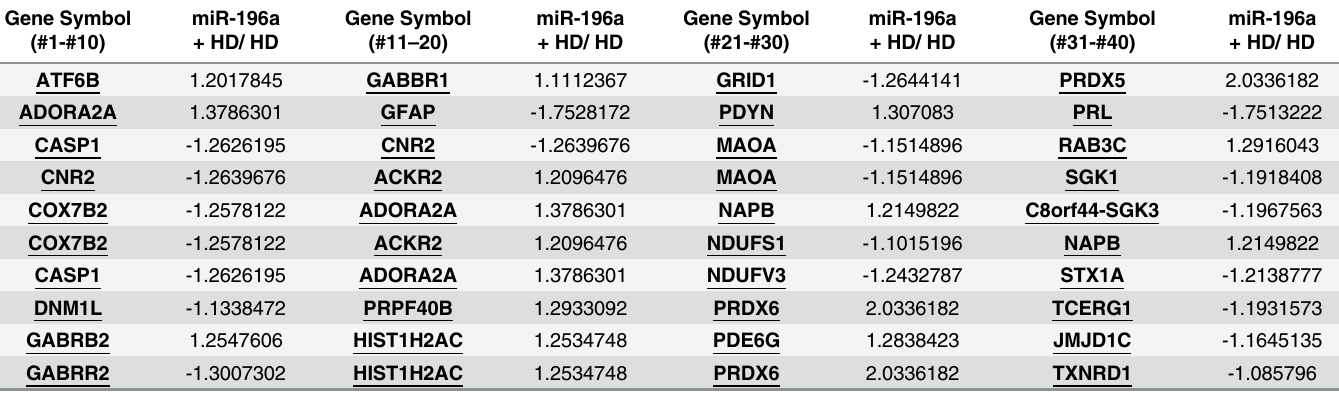
Table 2. Forty altered genes related to HD from the microarray